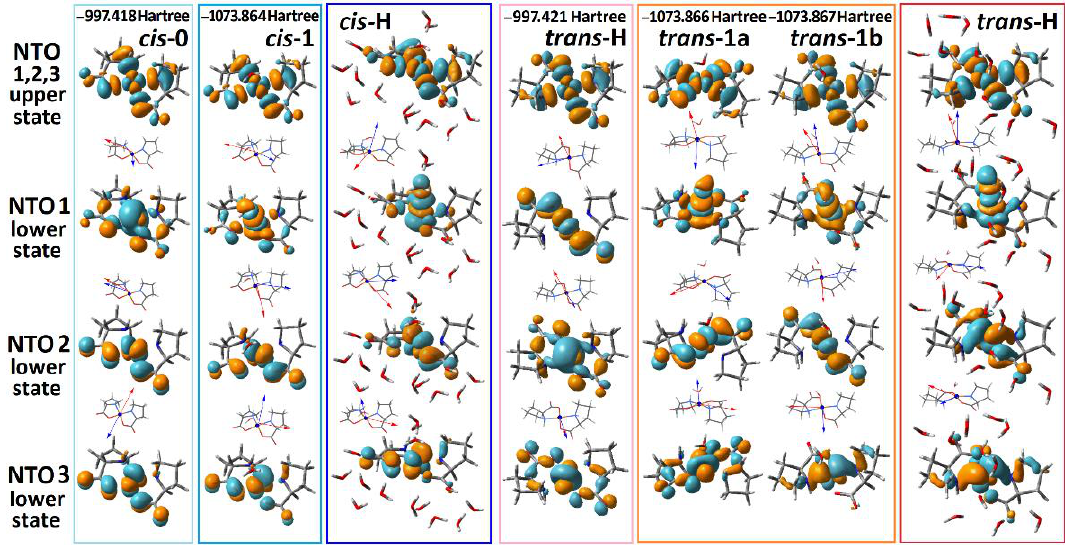
Figure 3. NTO presentation for the three lowest energy optical transitions that provide the optical transitions in the visible for the considered structural cases. Orientations of the computed transition electric (red) and magnetic (blue) dipole moments specific to the optical excitation with respect to the structures: we place the vector descriptions next to the images of the lower (departure) states of the NTO pairs because the three transitions share the same upper (arrival) state.